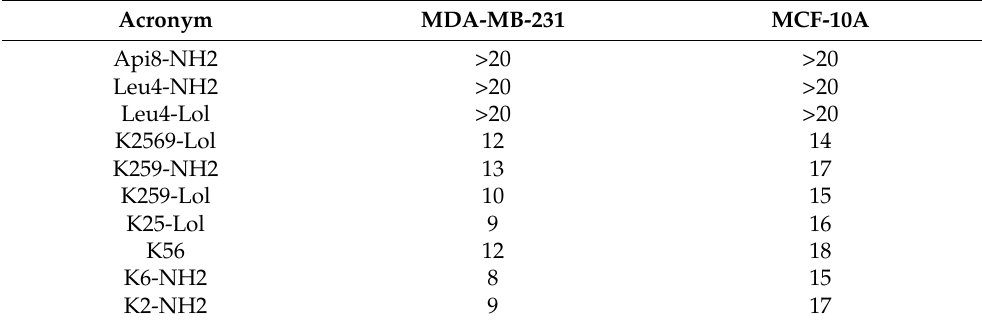
Table 3. IC 50 (expressed in µ M) values measured in MDA-MB-231 and MCF-10A cells exposed to peptaibols for 24